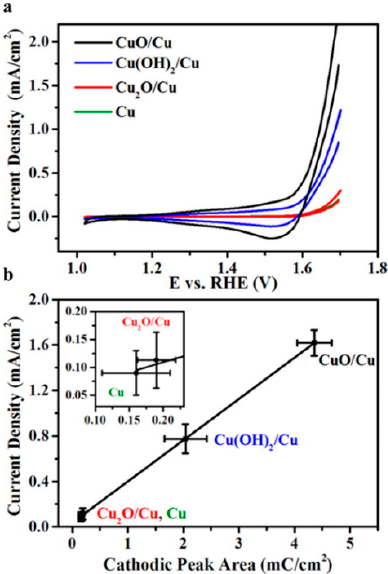
Figure 5. Performance evaluation of Cu-based OER-catalysts: ( a ) Cyclic voltammograms of Cu, CuO/Cu, Cu(OH) 2 /Cu, and Cu 2 O/Cu, after chronoamperometry at 0.7 V RHE (scan rate 0.01 V/s in 0.1 M KOH); CVs were scanned cathodically, at first. ( b ) Plot of the current densities as a function of charge of the reduction peaks at 1.55 V RHE (inset: enlarged view of Cu 2 O/Cu and Cu results). Reproduced from [17], with permission from the American Chemical Society, copyright 2016. Alternatively, a Cu(OH) 2 @CoCO 3 (OH) 2 nH 2 O core ‐ shell structure nanowire array was proposed